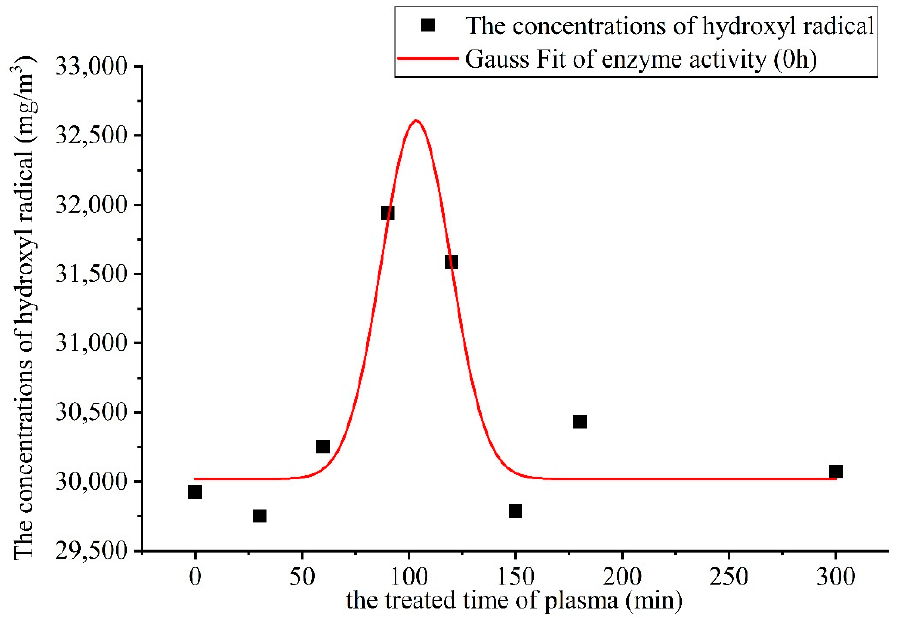
Figure 4. The relationship between α -amylase enzyme activity and duration of action.